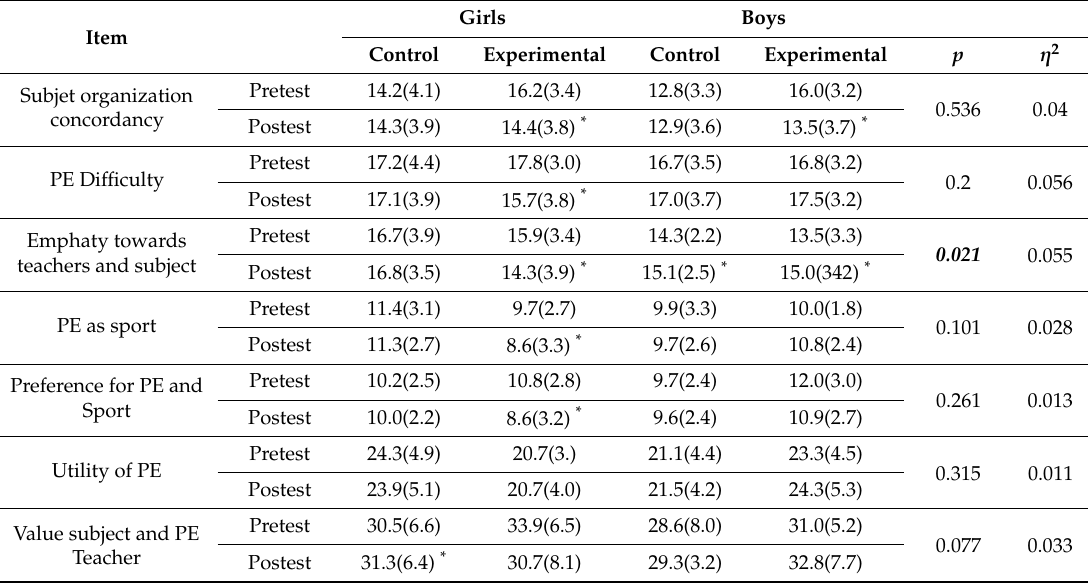
Table 5. Pre and post values of the study subjects on each